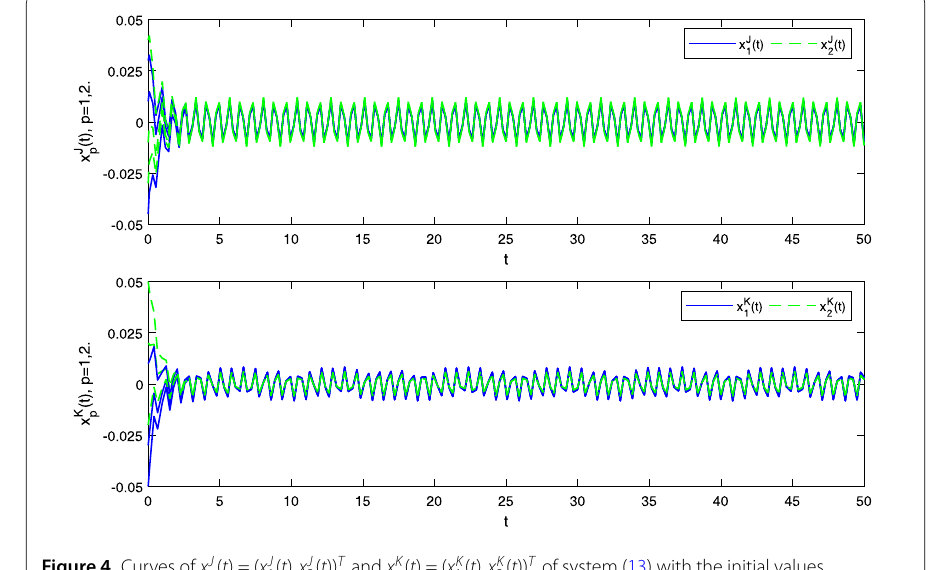
Figure 4 Curves of x J p ( t ) = ( x J 1 ( t ), x J 2 ( t )) T and x K p ( t ) = ( x K 1 ( t ), x K 2 ( t )) T of system (13) with the initial values